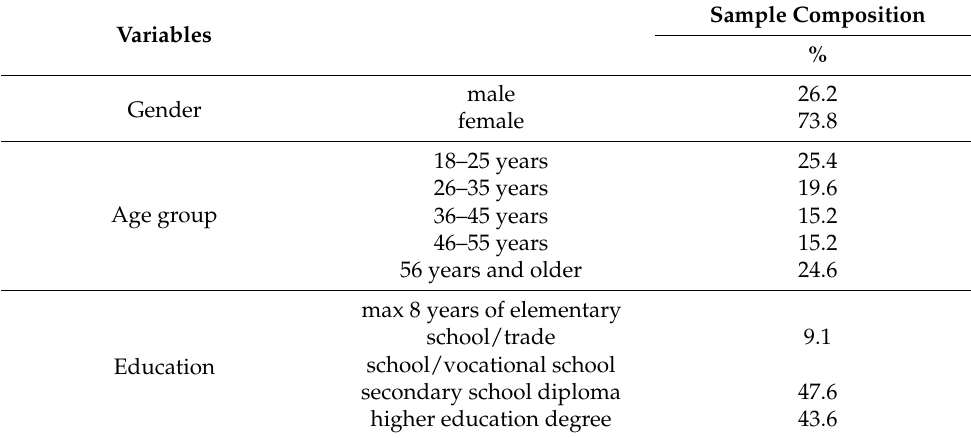
Table 1. Respondents’ demographic and other characteristics ( n =